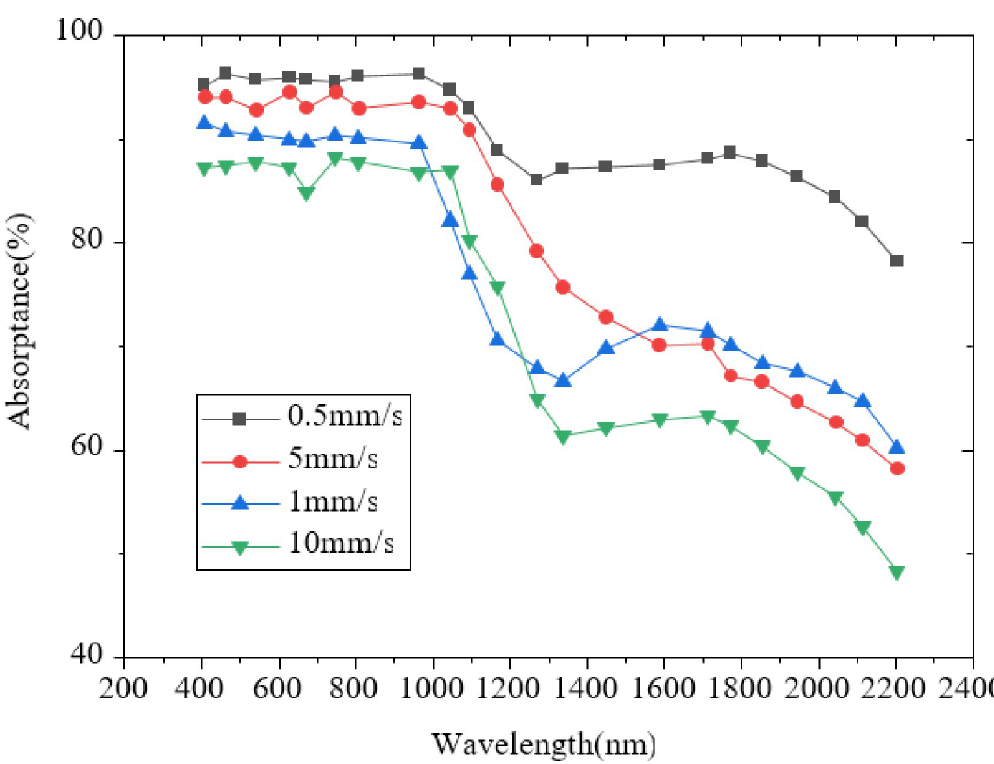
Fig 8. Comparison of absorption spectra of two-layer film samples at different scanning rates.